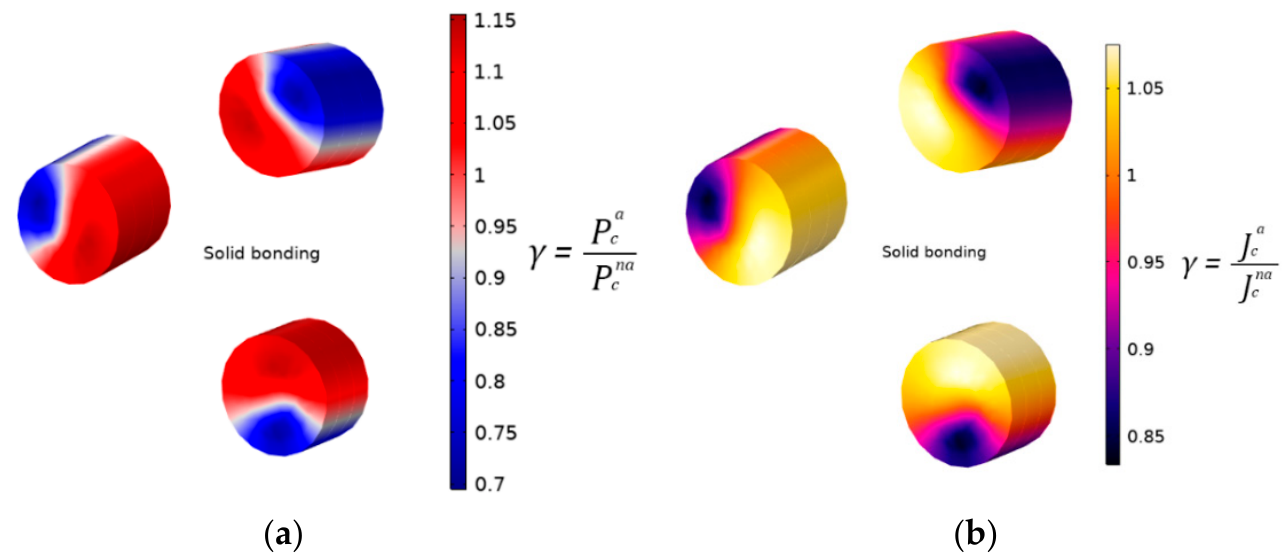
13 of 23 Figure 11. Variation of conductor losses with the armor permeability and ( a ) the conductor twisting or ( b ) the armor twisting in Cable 6 (SB). L c 6 ( L a 6 ): actual conductor (armor) lay length. A first conclusion arises from the results regarding the stainless-steel armor ( µ r = 1 − (cid:1862) 0), since it has no effects on the conductor losses as the results overlap with those obtained for an unarmored cable. In both cases the results are quite close to those derived by [5], especially when the corrections previously suggested are applied (“ P c corr”). However, in presence of a magnetic armor a different behavior is observed, since P c increases with µ r , especially when conductors are more twisted (Figure 11a), leading to important differ- ences with regard to the values provided by [5]. Furthermore, the lay length of the armor also influences the conductor losses, but to a lesser extent (Figure 11b). The reasons for these results come again from the use of (cid:2011) . In this case, Figure 12a,b illustrates, respectively, the changes in the conductor losses and the current density dis- tribution when switching from absence ( (cid:1842) (cid:3030)(cid:3041)(cid:3028) , (cid:1836) (cid:3030)(cid:3041)(cid:3028) ) to presence ( (cid:1842) (cid:3030)(cid:3028) , (cid:1836) (cid:3030)(cid:3028) ) of armor. The results show how both losses and current density increase in areas close to the center of the cable, whereas it strongly decreases in the most external regions of the conductors. This can be understood as an increase in the proximity effect inside the conductors since the current density moves towards the inner region of the cable. This conclusion is in line with recent recommendations [30] regarding the application of a factor of 1.5 to both y s and y p for